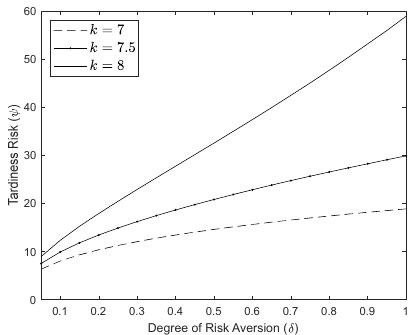
Fig. 4. The effect of degree of risk aversion on the effort level